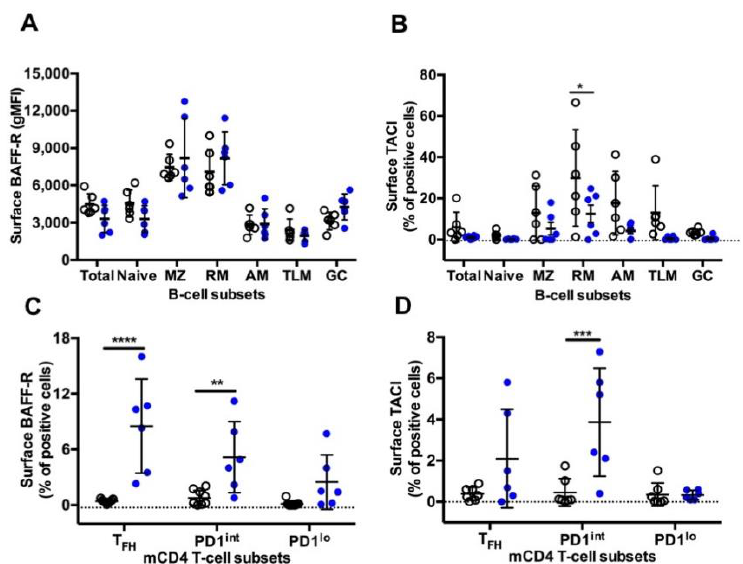
Figure 6. BAFF-R and TACI expression on splenic B-cells and mCD4 T-cell subsets from Groups SIV + and TT. Surface expression of ( A ) BAFF-R (gMFI) (Table S3, Panel 5) and ( B ) TACI (% of positive cells) (Table S3, Panel 6) was analysed in every B-cell subset from macaques of SIV + ( n = 6 ) and TT ( n = 6 ) groups. Surface expression of ( C ) BAFF-R (Table S3, Panel 7) and ( D ) TACI (Table S3, Panel 8) (% of positive cells) was simultaneously determined in every mCD4 T-cell subset from macaques of SIV + ( n = 9 ) and TT ( n = 6 ) groups. Each dot represents one macaque from the SIV + ( open circle ) or TT ( blue circle ) group. Bars represent Mean ±SD. Statistical comparison between groups was performed using 2-way ANOVA with Bonferroni’s multiple comparisons test. Statistically significant values are indicated: * p < 0.05 , ** p < 0.01 , *** p < 0.001 and **** p < 0.0001.